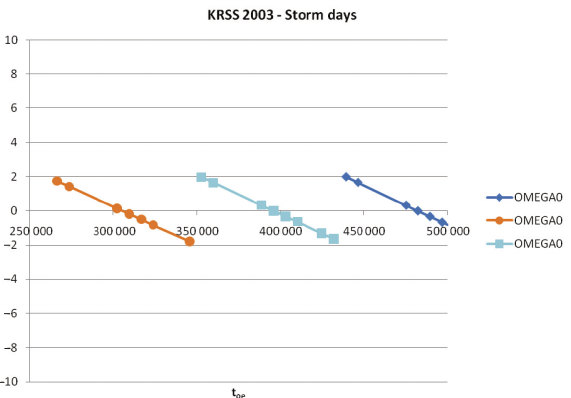
Fig. 1. Right ascension of the ascending node during three stormy days in 2003 using cPOS stations